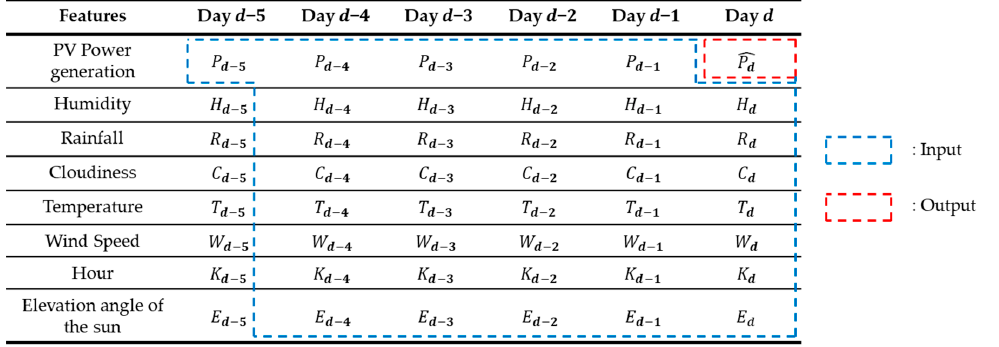
Figure 3. Inputs and outputs at the training phase .